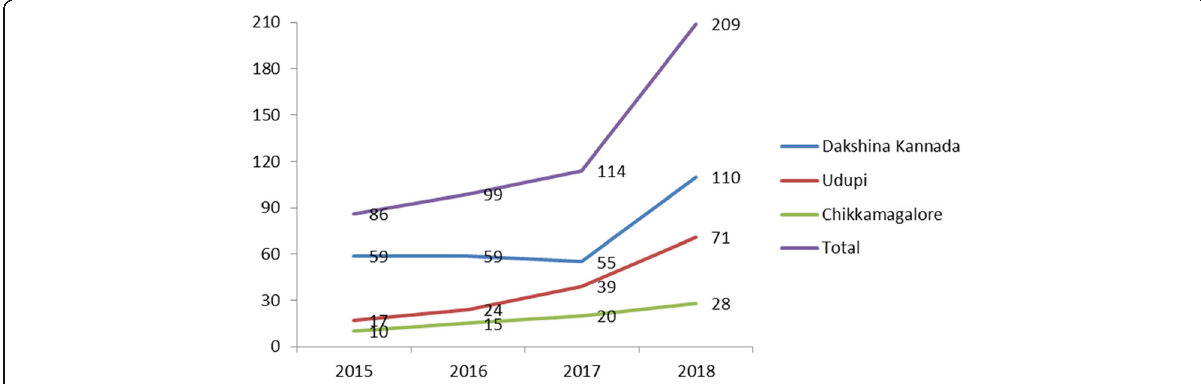
Fig. 2 The trends in DR-TB patients notified from the selected districts of Karnataka during 2015 to 2018, N =